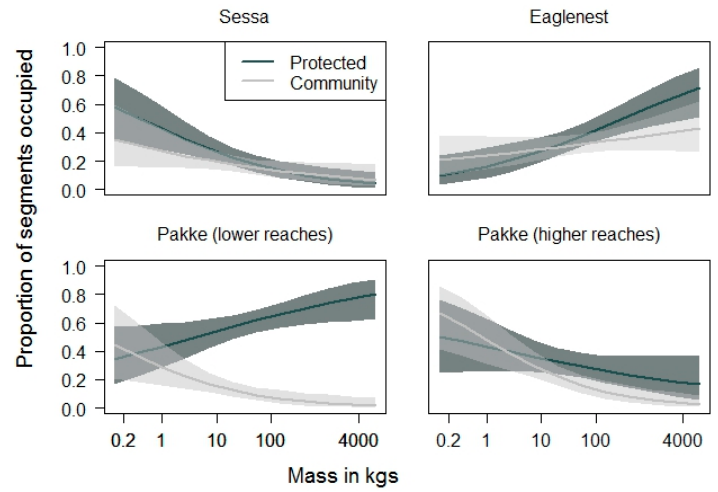
Figure 4. Probability of occurrence of terrestrial vertebrates as a function of body mass. Lines represent model predictions and the shaded dark and light grey regions 95% confidence intervals. The occurrence probability of large-bodied species declined more steeply in community-managed lands than in protected areas, at all locations except Sessa. Note that the x-axis is on a log scale.